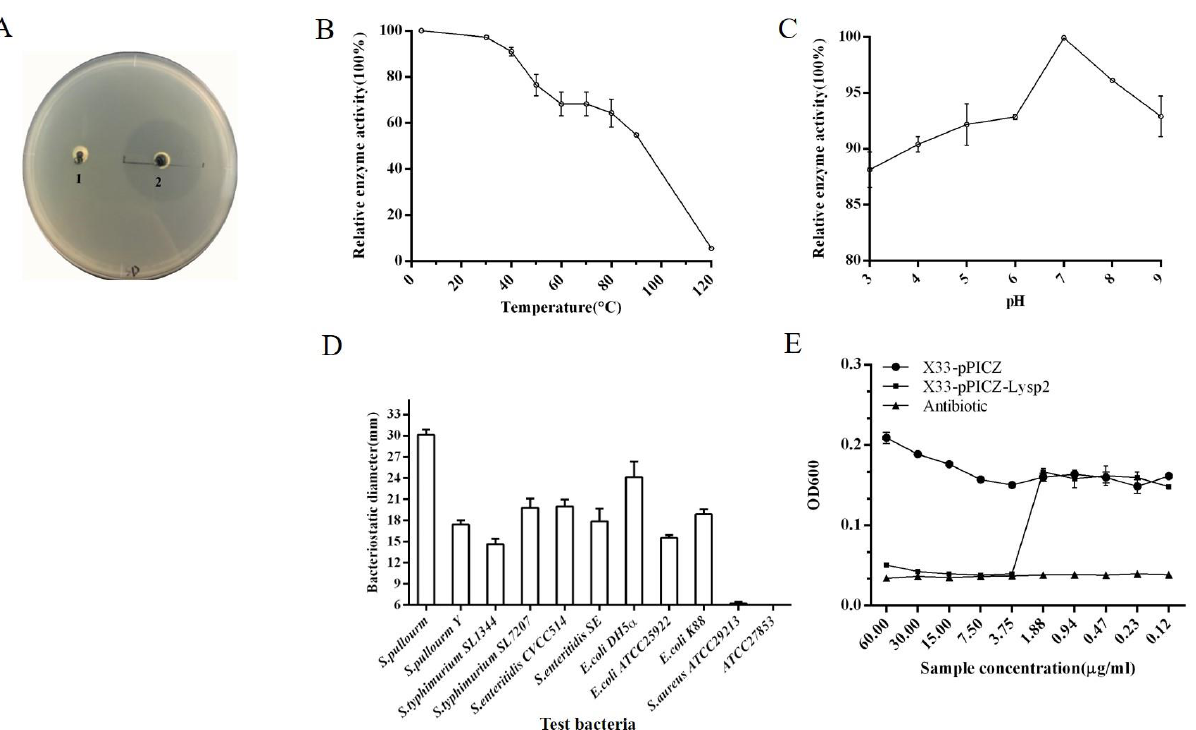
Figure 3. General biological characteristics of LySP2. ( A ) Activity of LySP2; add pPICZ to hole 1 and LySP2 to hole 2. ( B ) Effect of temperature on LySP2 activity. ( C ) Effect of pH on LySP2 activity. ( D ) Antibacterial activity of LySP2 against test bacteria. ( E ) Minimal inhibitory concentration of LySP2. Values are the mean ± SD of three determinations.